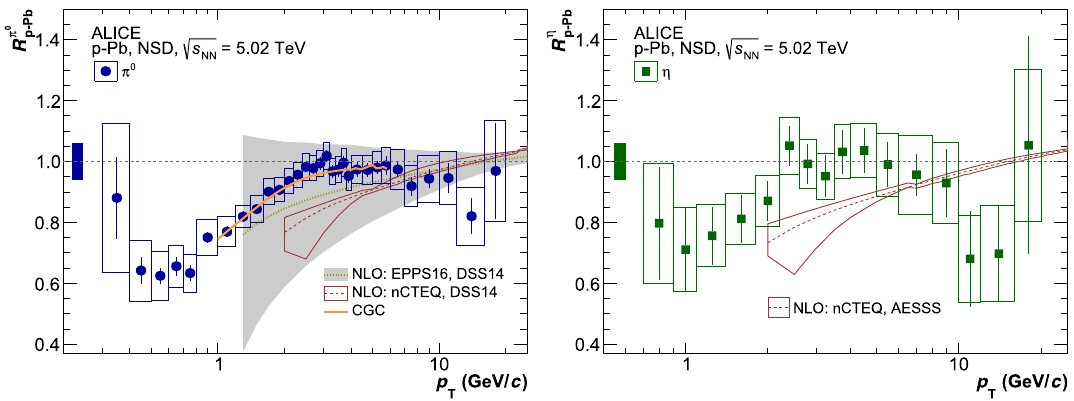
Fig. 11 Comparison of different theoretical model calculations to the π 0 (left) and η (right) nuclear modification factors R NSD p–Pb collisions at − 1 . 365 < y cms < 0 . 435 at The grey band shows a pQCD calculation at NLO using the EPPS16 nPDF [96], the CT14 PDF [100] and the DSS14 FF [15] including sys-